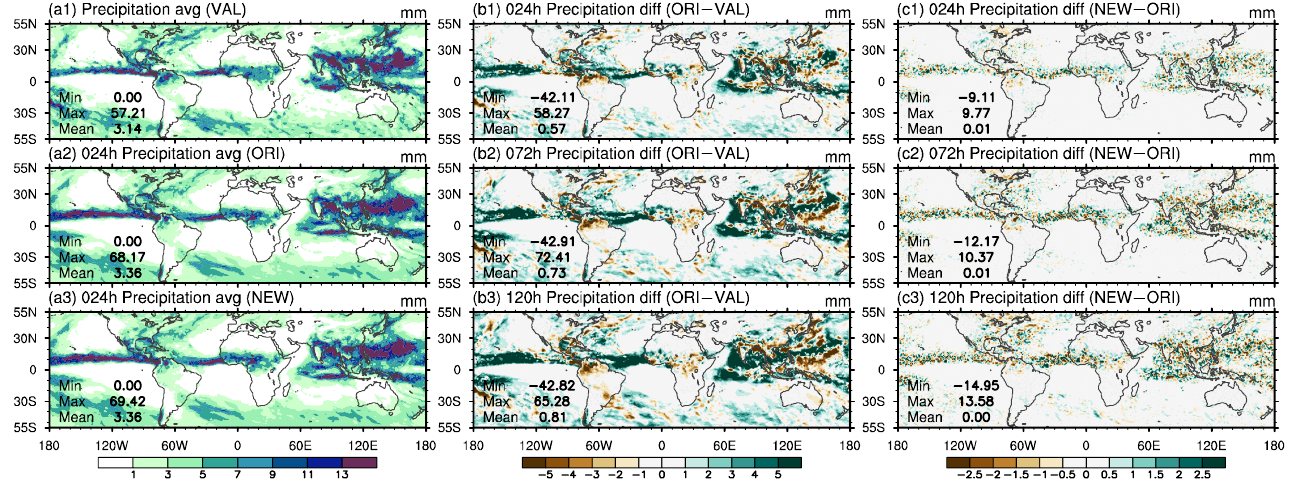
Figure 8. Spatial distribution of time-averaged 24 h net precipitation derived from ( a1 ) GPM dataset, ( a2 ) GRAPES_ORI 24 h forecast results, and ( a3 ) GRAPES_NEW 24 h forecast results; difference in time-averaged 24 h net precipitation between ( b1 ) GRAPES_ORI 24 h forecast results, ( b2 ) GRAPES_ORI 72 h forecast results, ( b3 ) GRAPES_ORI 120 h forecast results and GPM at the corresponding time; difference in time-averaged 24 h net precipitation between ( c1 ) GRAPES_NEW 24 h forecast results, ( c2 ) GRAPES_NEW 72 h forecast results, ( c3 ) GRAPES_NEW 120 h forecast results and GRAPES_ORI forecast results at the corresponding forecast lengths (units: mm).